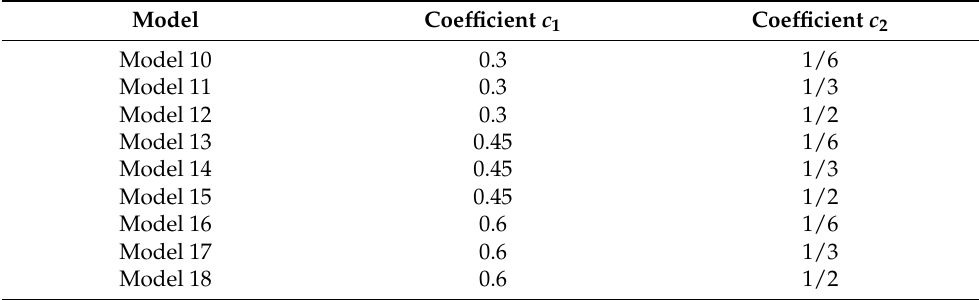
Table 2. The parameters of the arc-shaped reflux groove